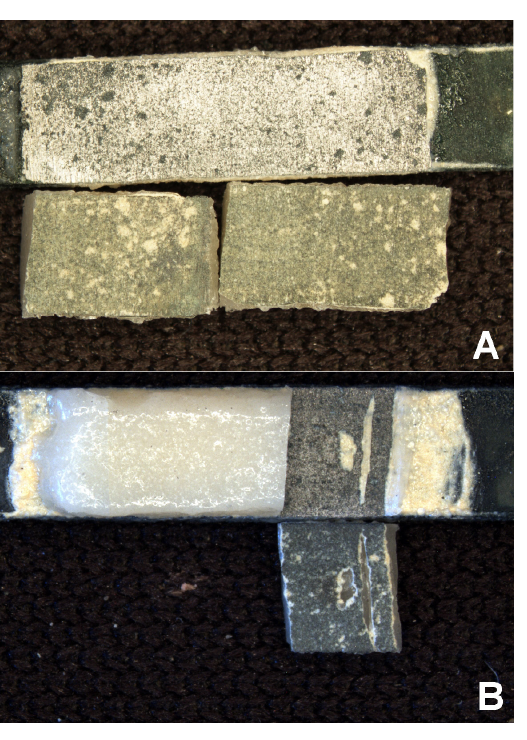
Figure 2. Type of failure: A - Adhesive failure; B - Mixed